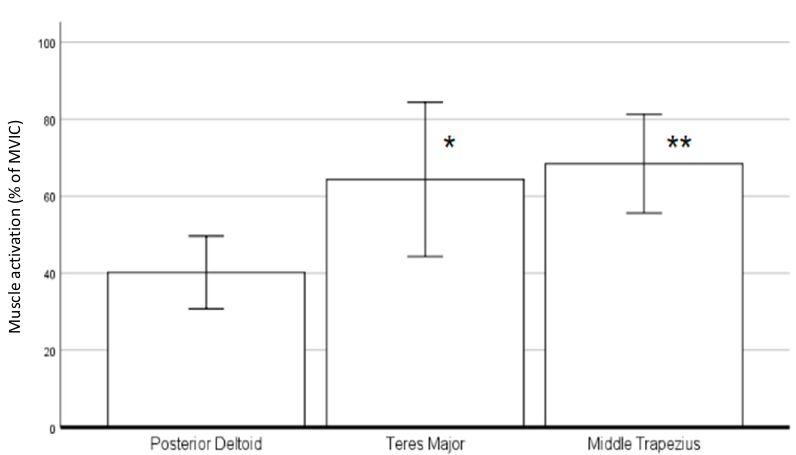
Figure 5. Muscle activity in middle phase (in % of MVIC). * Significantly higher muscle activation than posterior deltoid ( p = 0.04). ** Significantly higher muscle activation than posterior deltoid ( p < 0.01) .